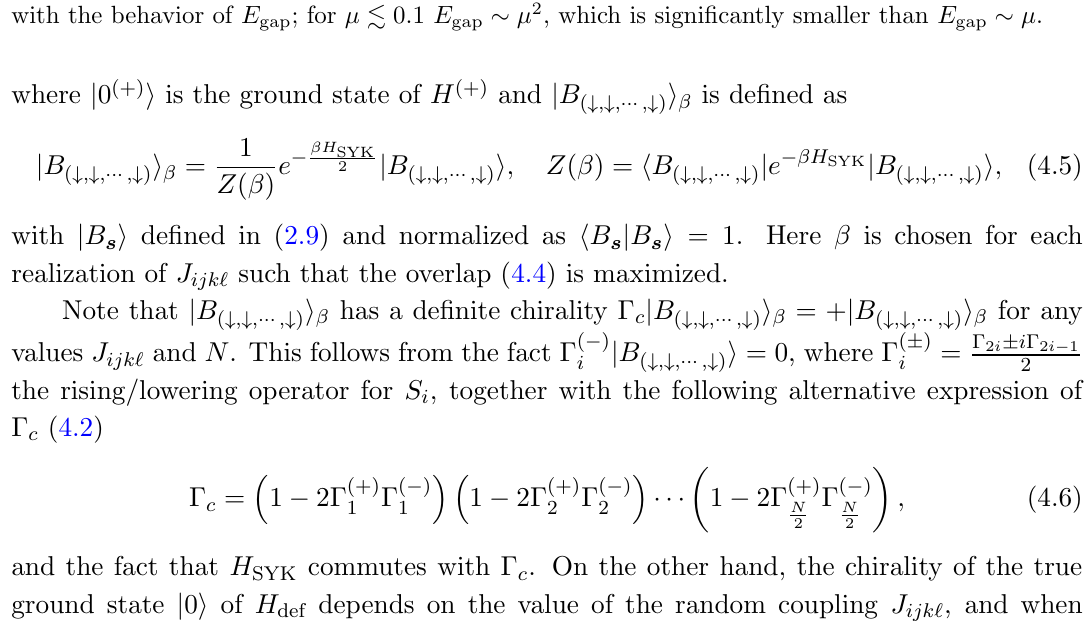
Figure 11 . Eigenvalue density of the Hamiltonian H def with q = 4, J = 1 (4.1) and N = 30, with a single realization of J ijk‘ . We observe that the shape of the eigenvalue density around the ground state exhibits a transition around (cid:22) 0 : 1 from a hard edge to a smooth decay, which is (cid:25)